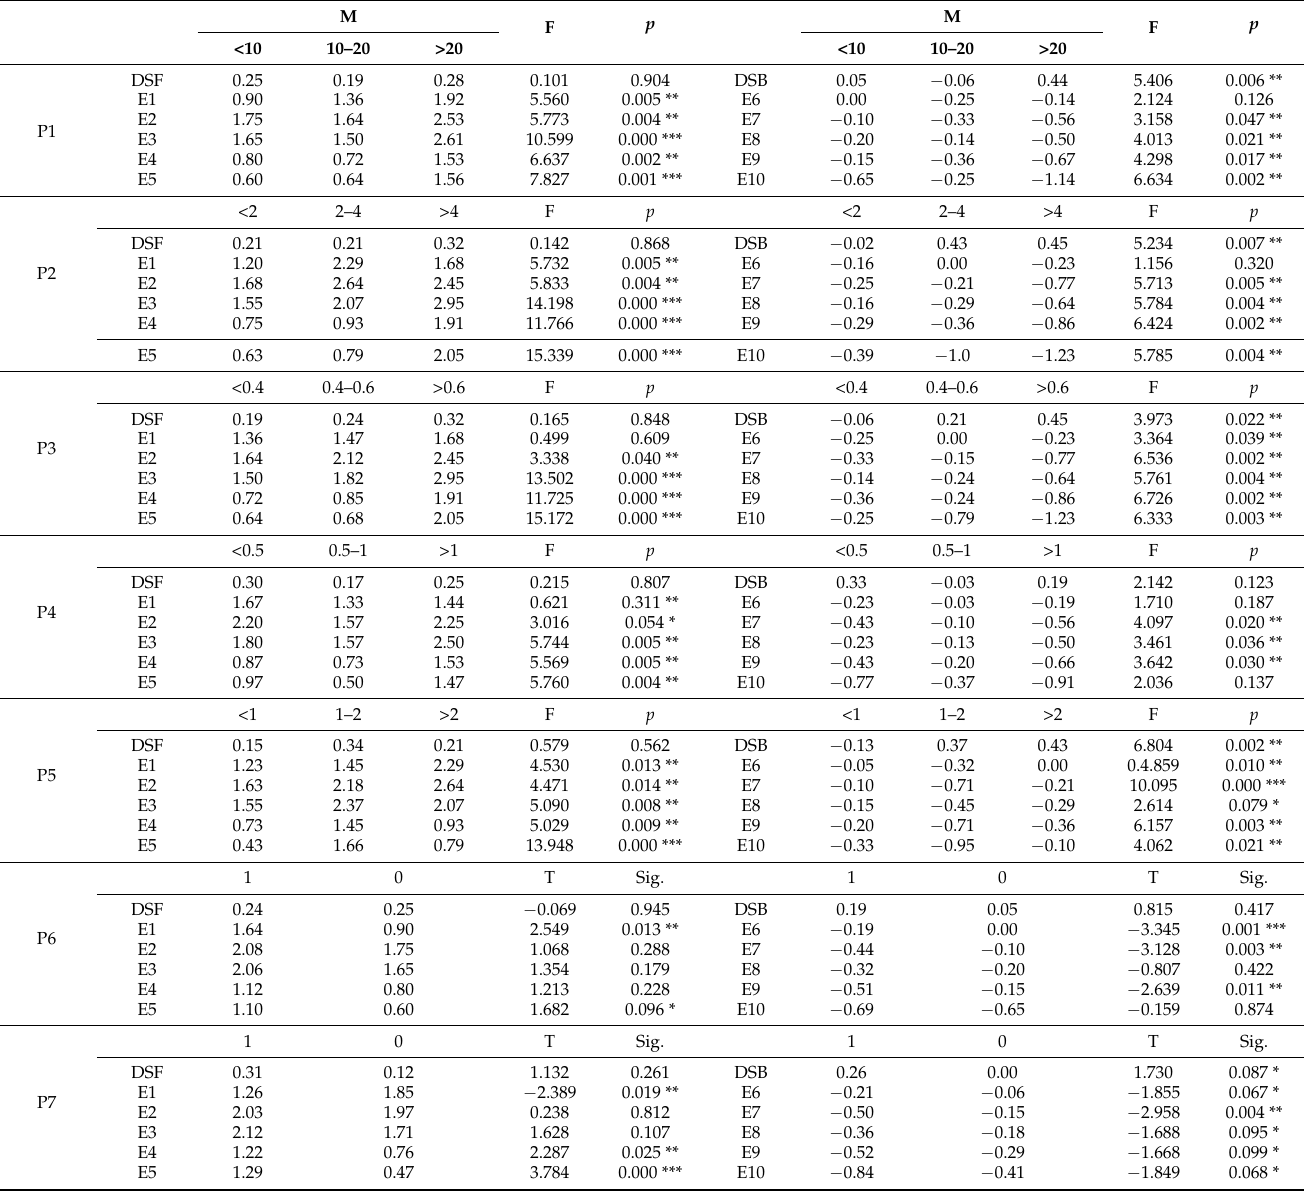
Table 7. Differences in restorative effects of different park